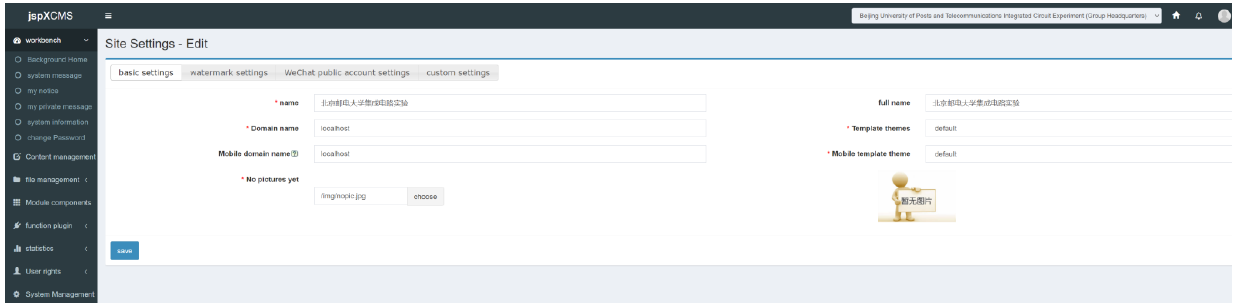
Figure 18. Website back-end management system interface. The non-English part is the emblem, name or the website title of BUPT.